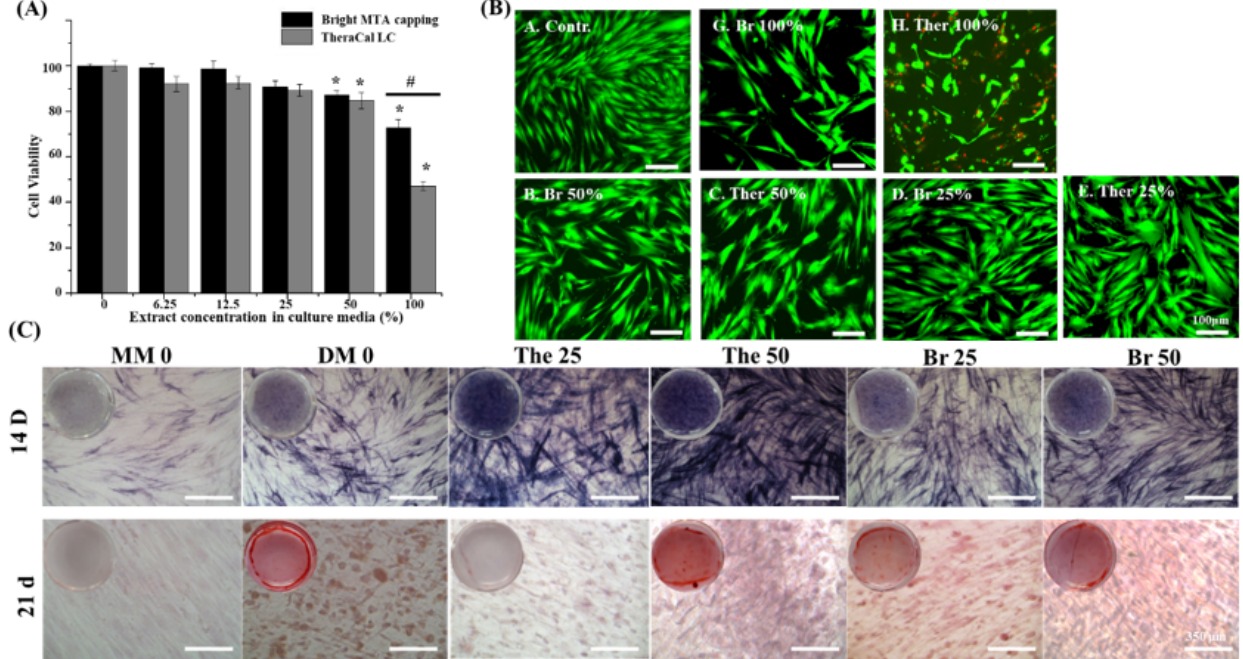
Figure 5. Cell viability and odontoblastic differentiation of nanoparticle-incorporated, light-curable MTA ( A ) Cell viability at various concentrations of extracts from TheraCal LC and bright MTA capping (n = 3, p < 0.05). Asterisks (*) indicate statistical significance between bright MTA and TheraCal LC’s cell viability based on the 0% of extract culture media. (#) the symbol indicates statistical significance between bright MTA and TheraCal LC’s cell viability at 100% extract culture media result. ( B ) Live and dead cells exposed to 25%, 50%, and 100% concentrations of extracts from bright MTA capping and TheraCal LC. Live (green) and dead (red) cells were observed by fluorescence microscopy (scale bar = 100 µ m). Washing steps were performed before live and dead staining to ensure that only intact live cells remained on the plate (scale bar = 350 µ m). ( C ) Odontoblastic differentiation under the use of Bright MTA and TheraCal LC was evaluated with alkaline phosphatase (ALP) activity (14 days) and calcium deposition (21 days) evaluated by alizarin red S (ARS) staining. ALP staining after 14 days revealed that 25% concentrations of extracts from both Bright MTA and TheraCal LC deposited a larger amount of phosphate than 50% concentrations. ARS staining after 21 days indicated a large amount of deposition in the 25% concentrations of extracts from both Bright MTA and TheraCal